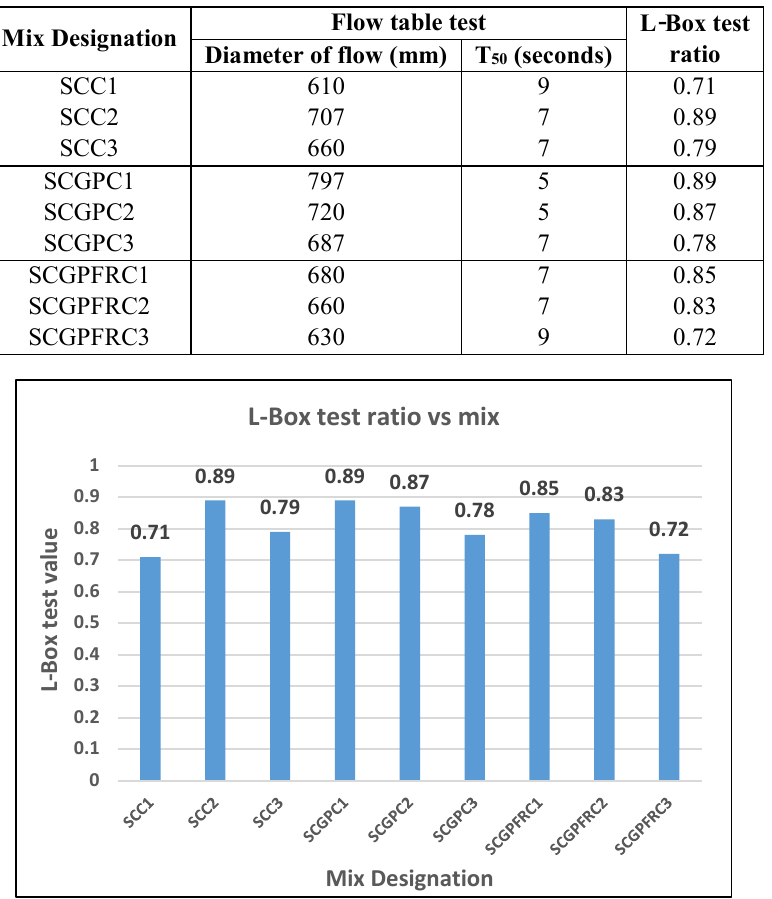
Fresh properties values for all mixes.